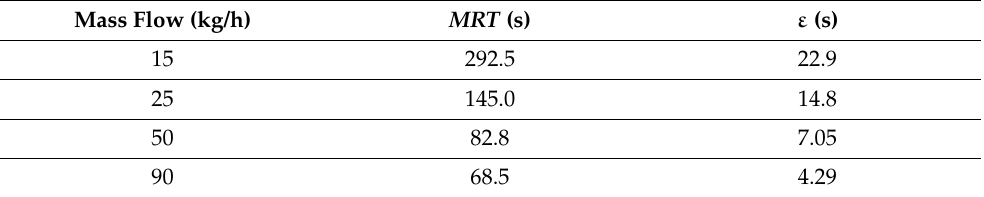
Table 4. Regressed Mean Residence Time Values and Goodness-of-Fit Values for the Feed Frame. Mass Flow (kg/h)